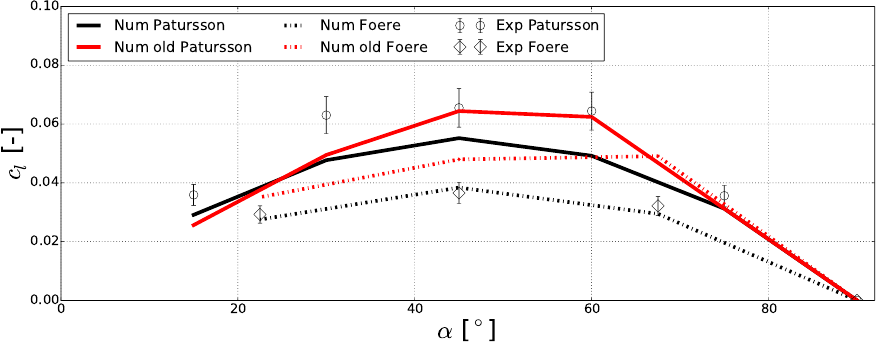
Figure 2. Comparison of the numerically predicted and measured lift force coefficients as a function of the angle of attack α . The experiments are taken from [7,24,25]. The bars indicate a 10% error margin. For additional validation, the velocity of the damped flow behind the net is compared to the experimental results in Figure 3. Here, only cases with perpendicular inflow but different inflow velocities are considered. The numerical model is capable of predicting the right amount of damping for all considered inflow velocities as the deviations are below 10%. This correct behaviour is particularly important for inflow velocities larger than 0.5 m/s because here, the net has a significant effect on the fluid flow.